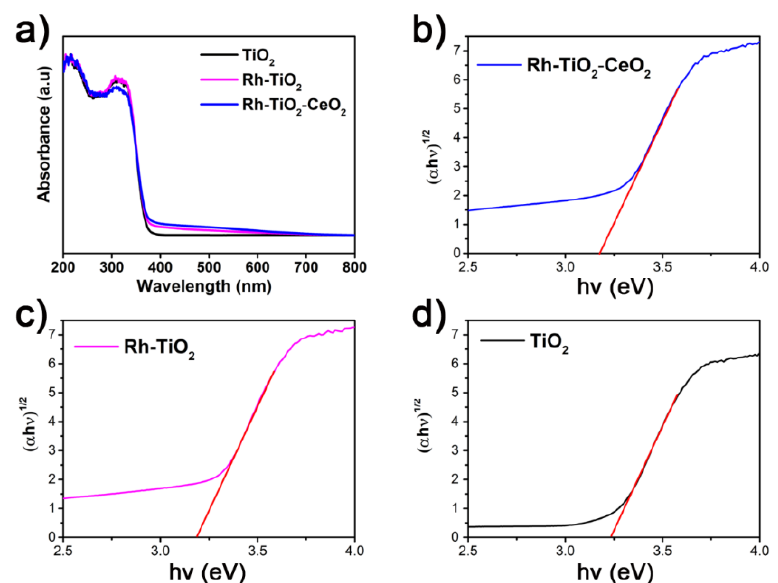
Figure 5. UV–Vis DRS of ( a ) Rh–TiO 2 –CeO 2 hybrid, Rh–TiO 2 hybrid, and TiO 2 photocatalysts and corresponding plots of the ( α h ν ) 0.5 versus photon energy (h ν ) for ( b ) Rh–TiO 2 –CeO 2 hybrid, ( c ) Rh–TiO 2 hybrid, and ( d ) TiO 2 photocatalysts.